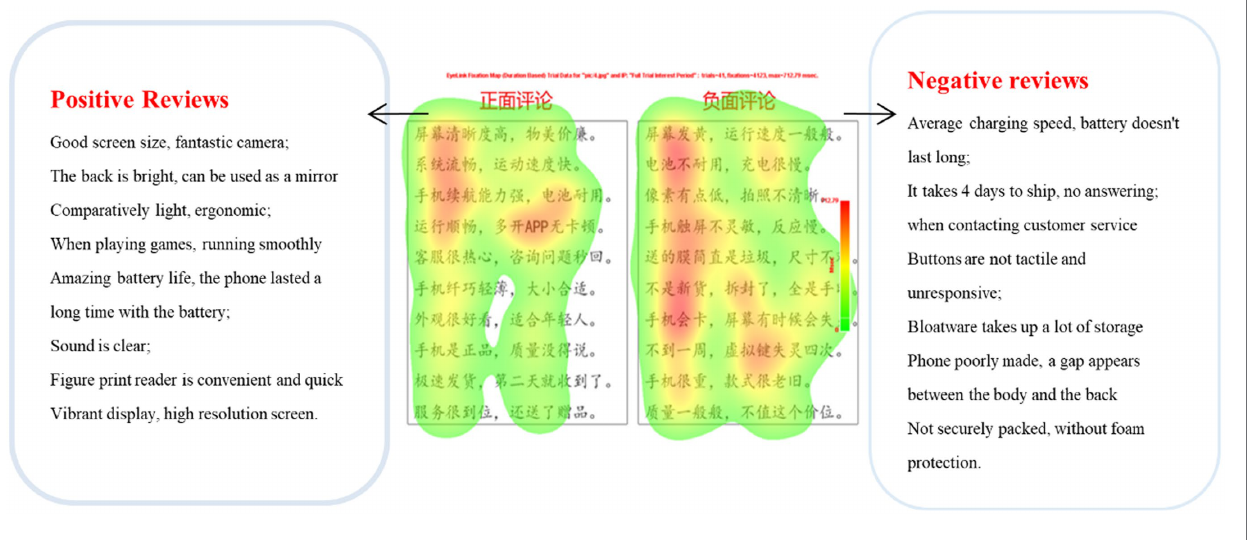
FIGURE 4 | Heat map of review picture.